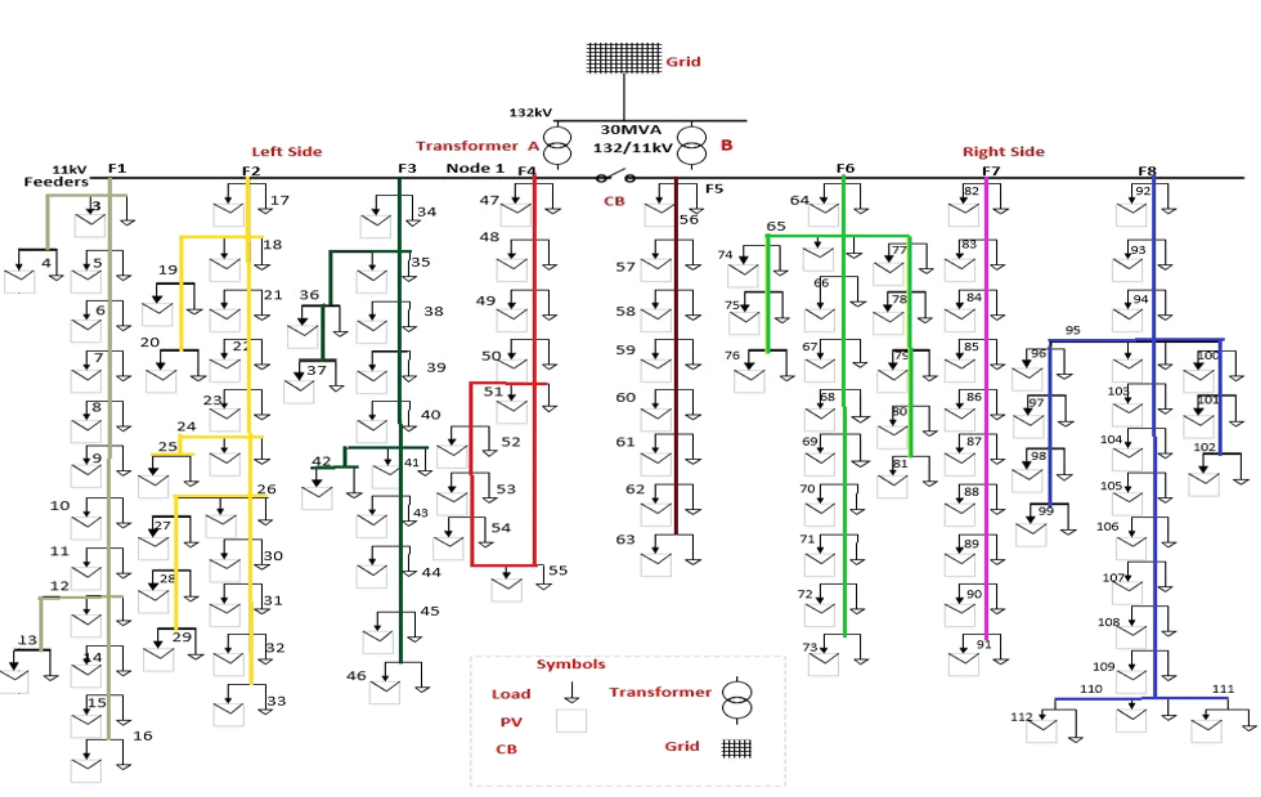
Figure 1. Network Topology. In parallel, two 132/11 kV, 30 MVA transformers are connected to a 11 kV bus bar to provide power to the grid. In the 11 kV busbar, 8 feeders in total serve 112 nodes.